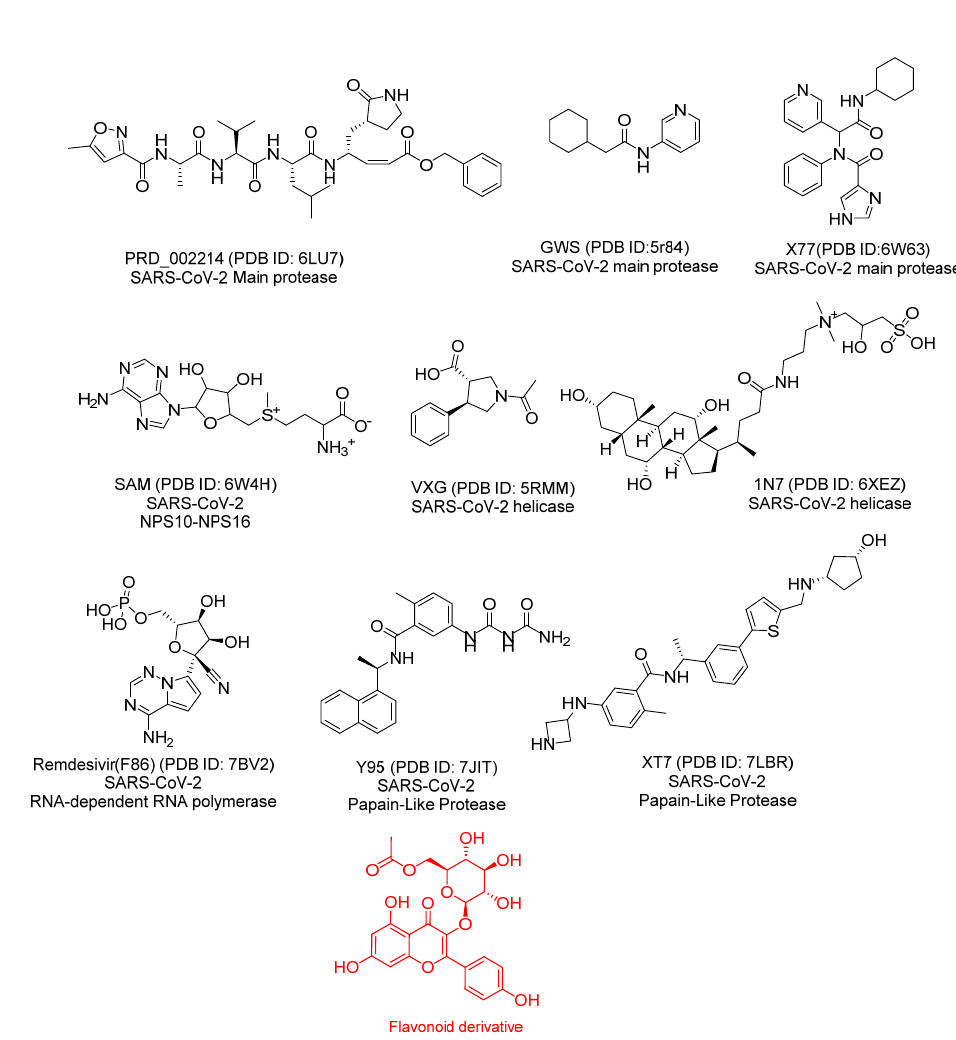
Figure 3. The chemical structures of the compared co-crystallized ligands of SARS-CoV-2 proteins and K3G-A (flavonoid derivative).